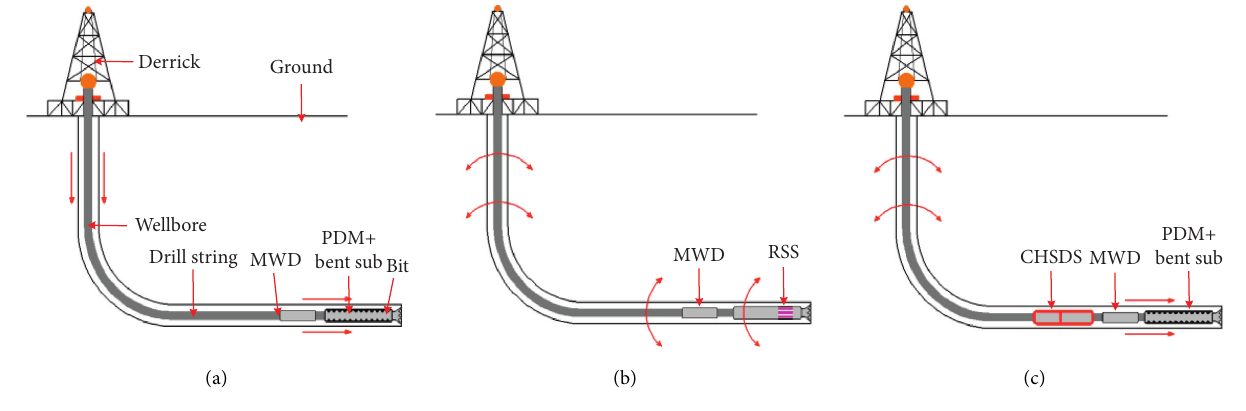
Figure 1: Comparison of CHSDS and conventional horizontal well drilling